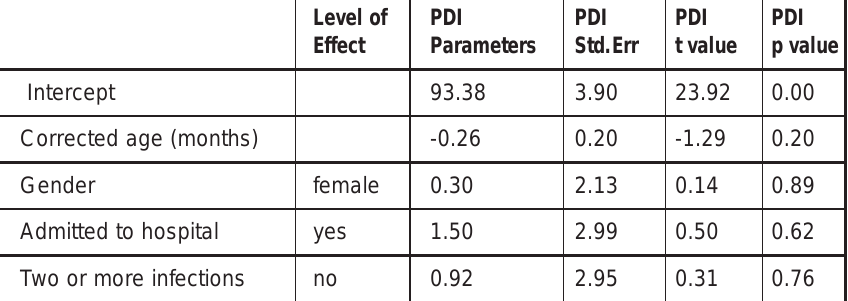
Table 4: Results of the GLM to determine interaction effects of the infant’s characteristics with the